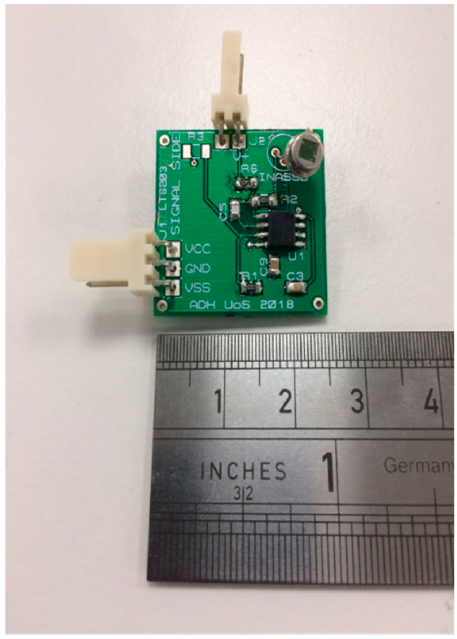
Figure 2. Illustration of PCB size for uncooled InAsSb photodiodes.